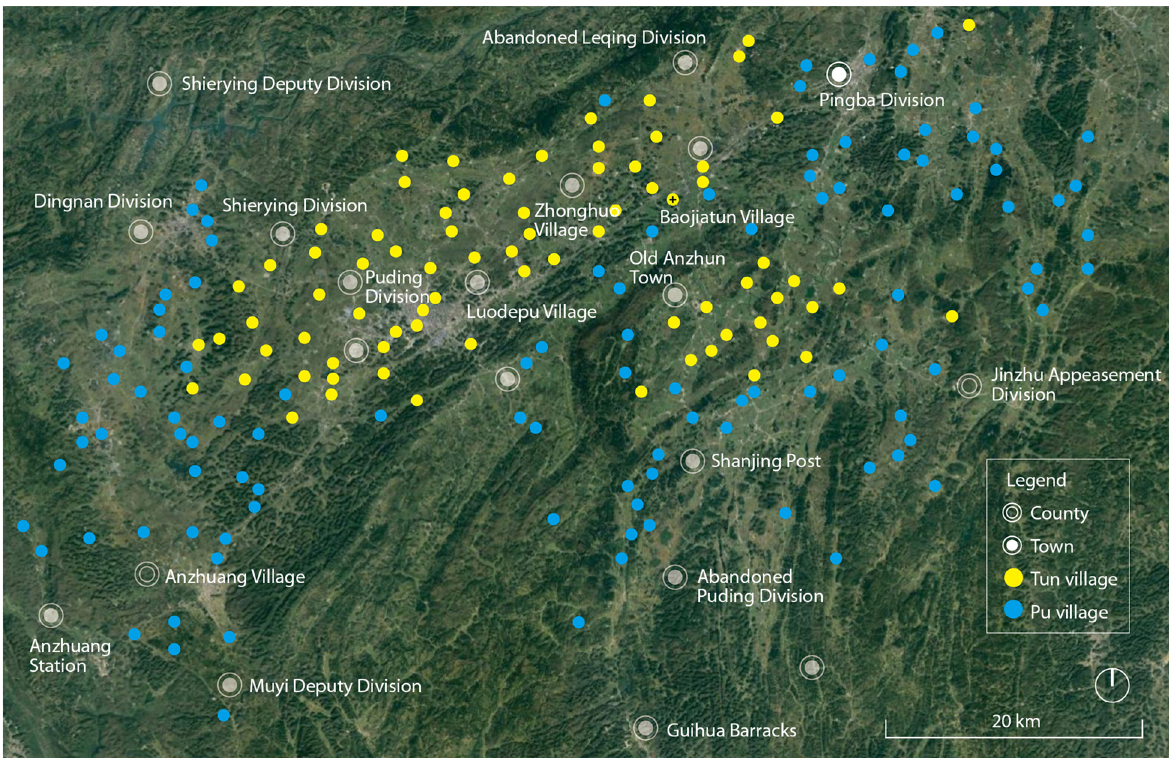
Fig. 1 Ming era distribution of tunpu village (Source: the authors)